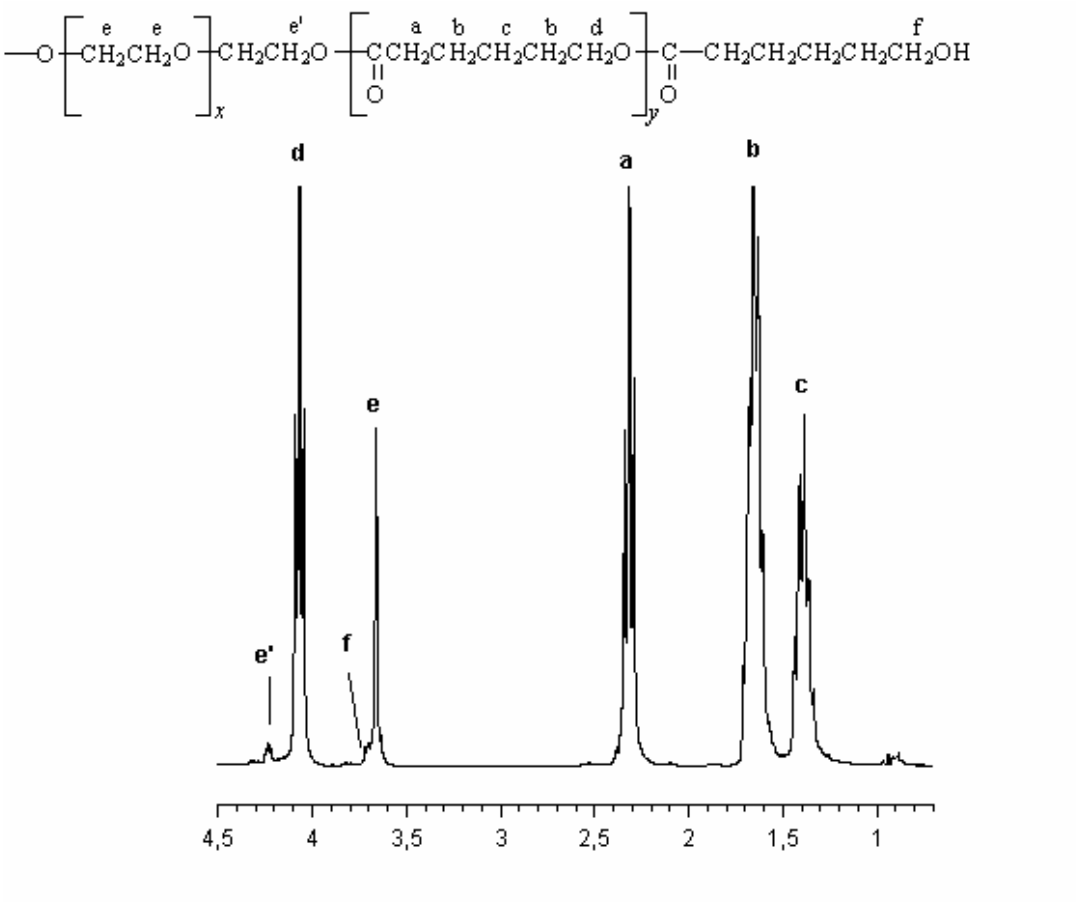
Figure 1 . 1 H-NMR spectrum of the two-armed PCL (in CDCl